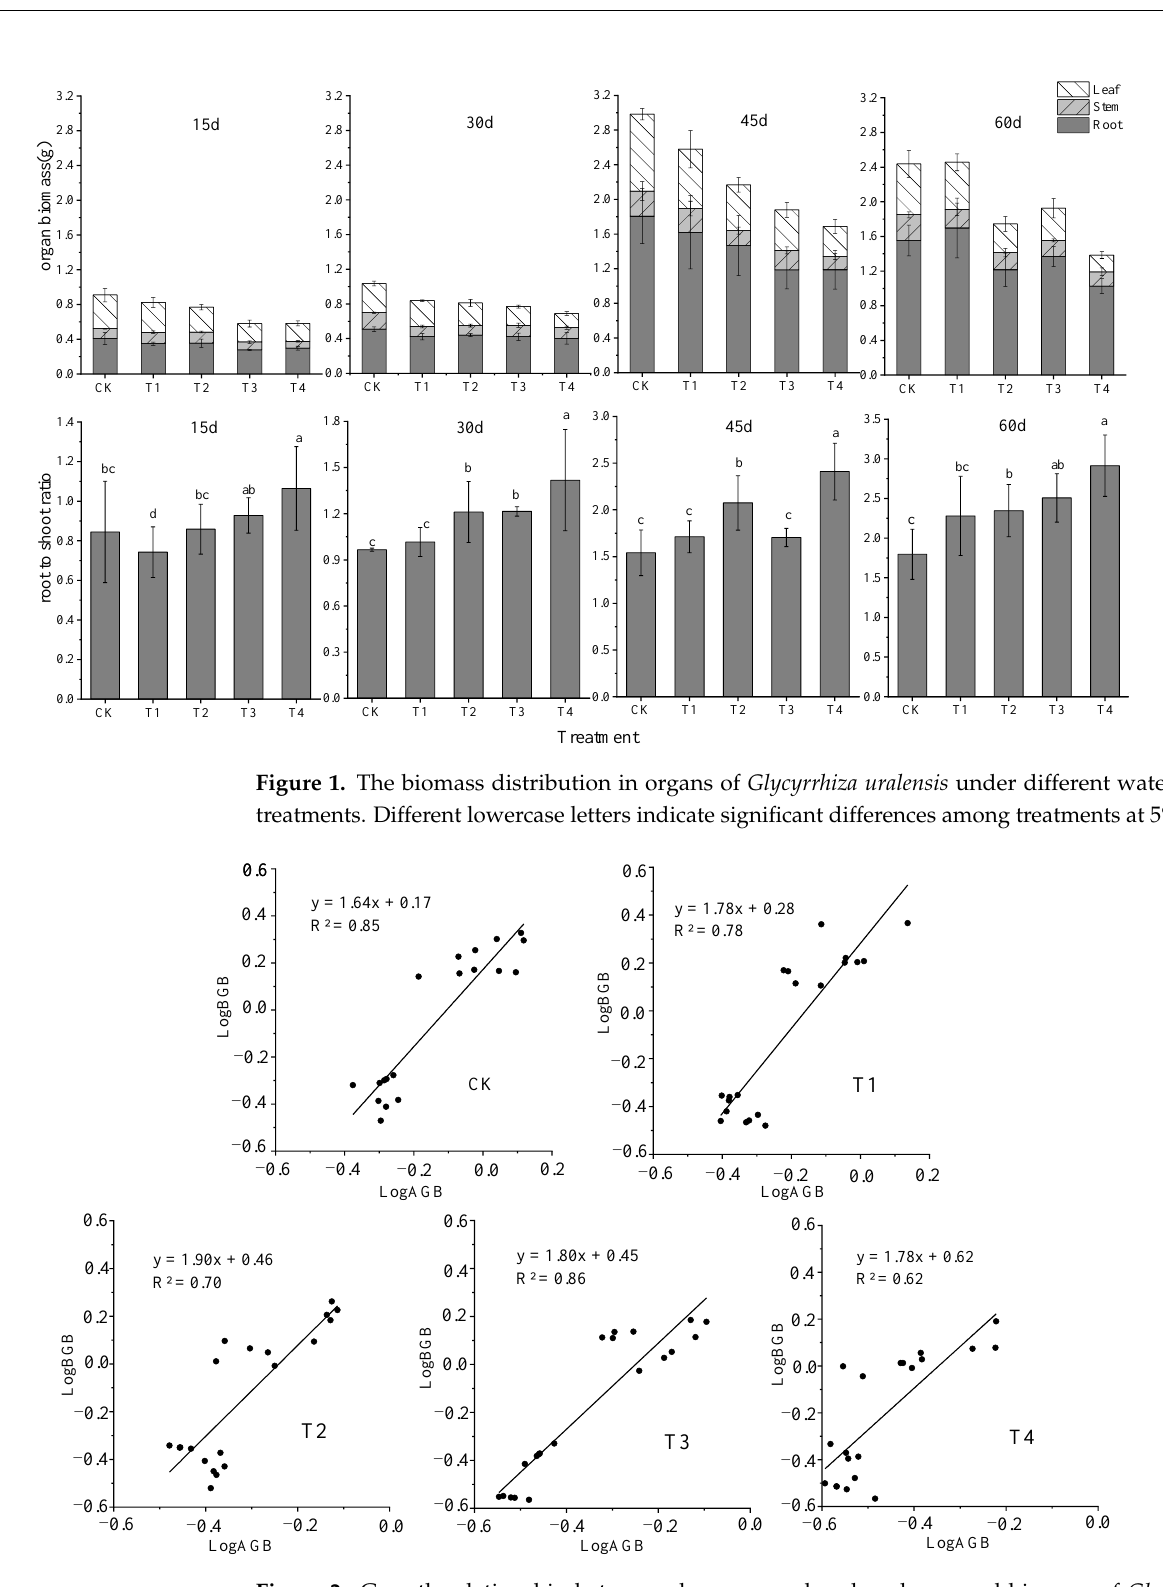
Figure 2. Growth relationship between above-ground and underground biomass of Glycyrrhiza uralensis in different water stress treatments. AGB and BGB represent the above-ground biomass and below-ground biomass. The biomass data are logarithmic transformed, its power function is converted to the form of log = log β + α logX, where α is the slope of linear regression, and log β is the intercept of linear